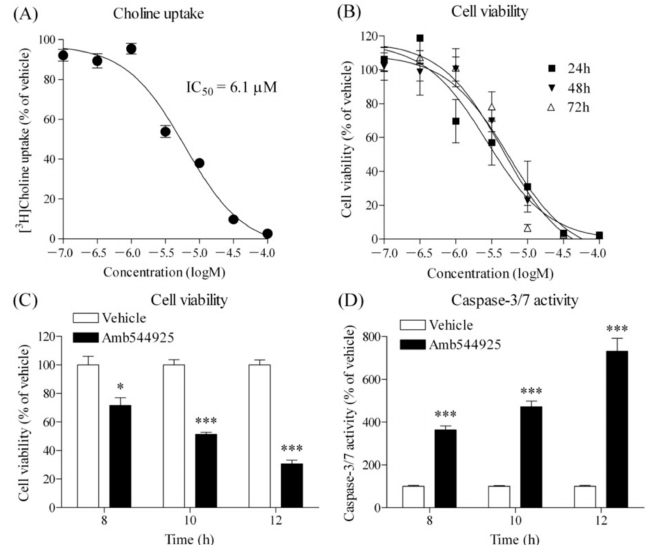
Figure 2. Effects of Amb544925 on [ 3 H]choline uptake, cell viability and caspase 3/7 activity in HSC-3 cells. ( A ) Effect of Amb544925 on 10 µ M [ 3 H]choline uptake ( n = 3). Cells were